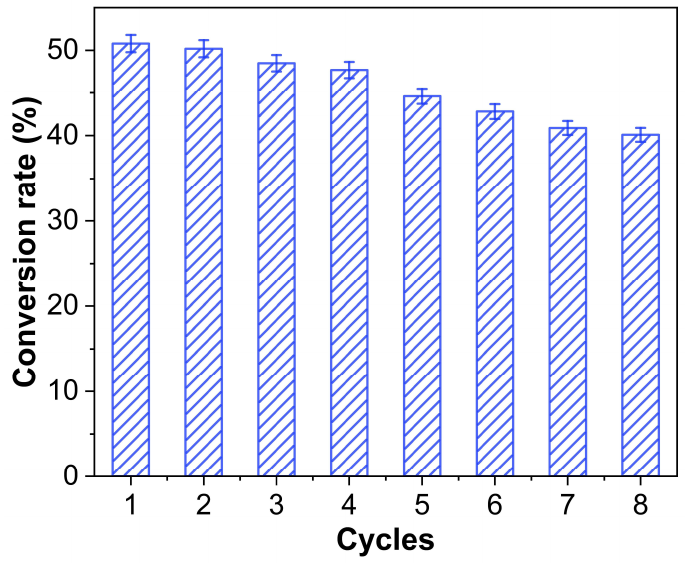
Figure 7. Recycling results of the ZCP-biocatalyzed kinetic resolution of p -NPP in the stirring-free Pickering HIPE system.